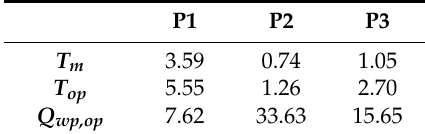
Table 5. Machining time, operation time and Q wp,op